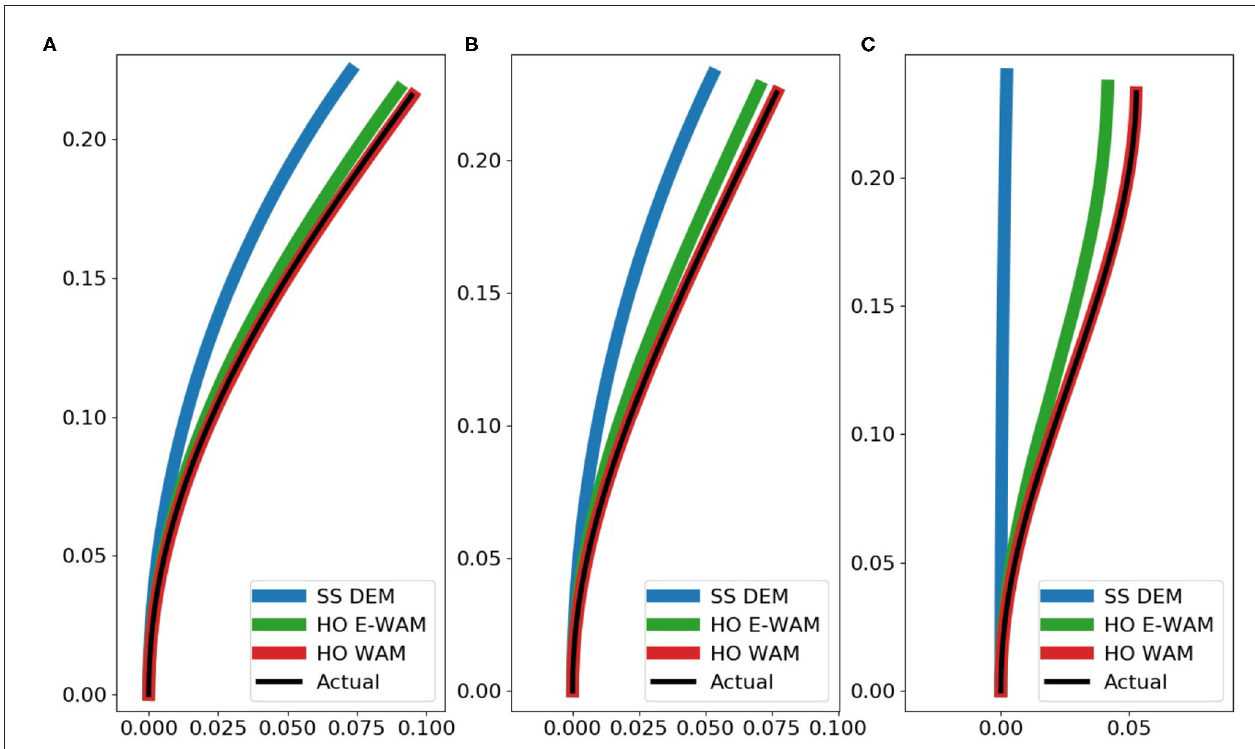
FIGURE 8 | Case study of effectiveness of estimation methods for a single case. Sensors placed using HO. Number of segments = 12, max ROM = 3 deg, and number of sensors = 3 placed at [0,4,3,8,7,11]. The plots show the following loading conditions: (A) end force load, (B) uniformly distributed load, (C) moment and end force load. All units in the plots are reported in meters.